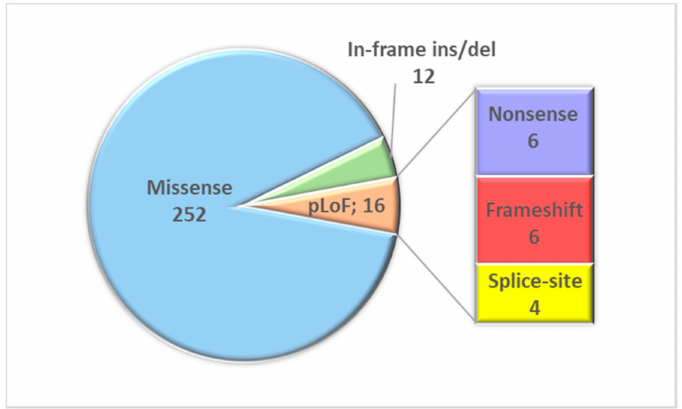
Figure 1. Distribution of the di ff erent variant types identified by gene panel sequencing (pLoF: Predicted loss-of-function).